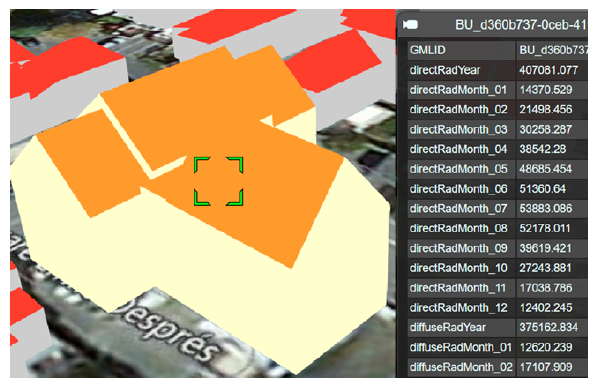
Figure 2. The tabular representation of monthly irradiation values of a building. Screenshot taken from (3DCityDB-Web- Map, 2017)